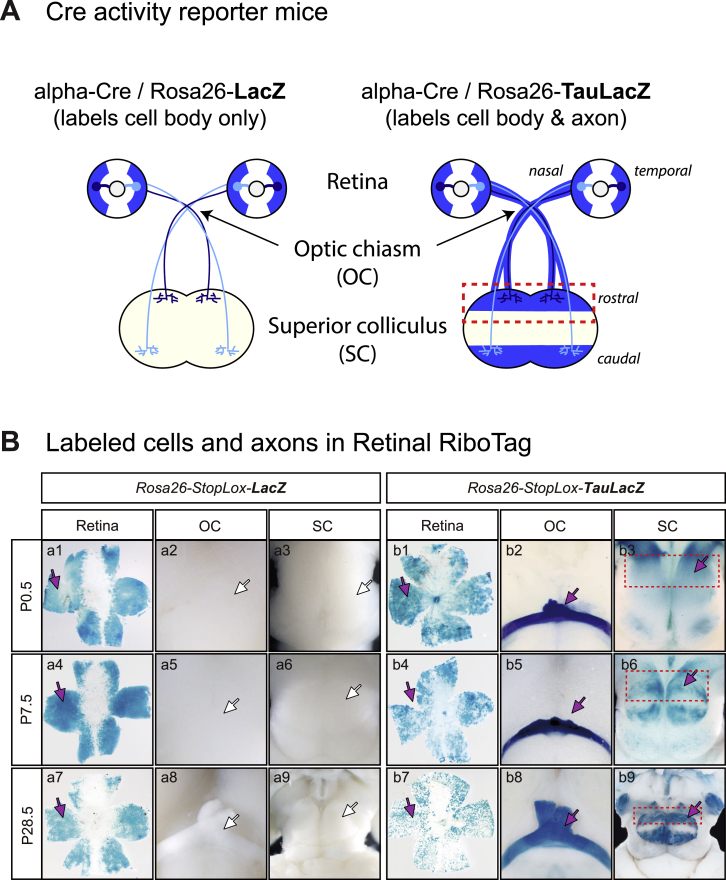
Specific Labeling of Retinal Axons in Retinal RiboTag, Related to Figure 1(A) Two Cre activity reporter mice were used in this study. The LacZ reporter labels the cell bodies of Cre-positive cells and their progeny, whereas the TauLacZ reporter labels both the cell bodies and axons.(B) X-gal staining of the retina, optic chiasm (OC) and superior colliculus (SC) in alpha-Cre; LacZ reporter gene double positive mice. Cre labels most peripheral neural retinal cells in both mice. No cells in the SC used for TRAP in this study express Cre as evidenced by the lack of X-gal stain in the LacZ reporter SC. Unlike the alpha-Cre; LacZ mice, alpha-Cre; TauLacZ mice show robust staining not only in the cell bodies but also the OC and the SC. The SC, which was used for axon-TRAP, is highly innervated by retinal axons.